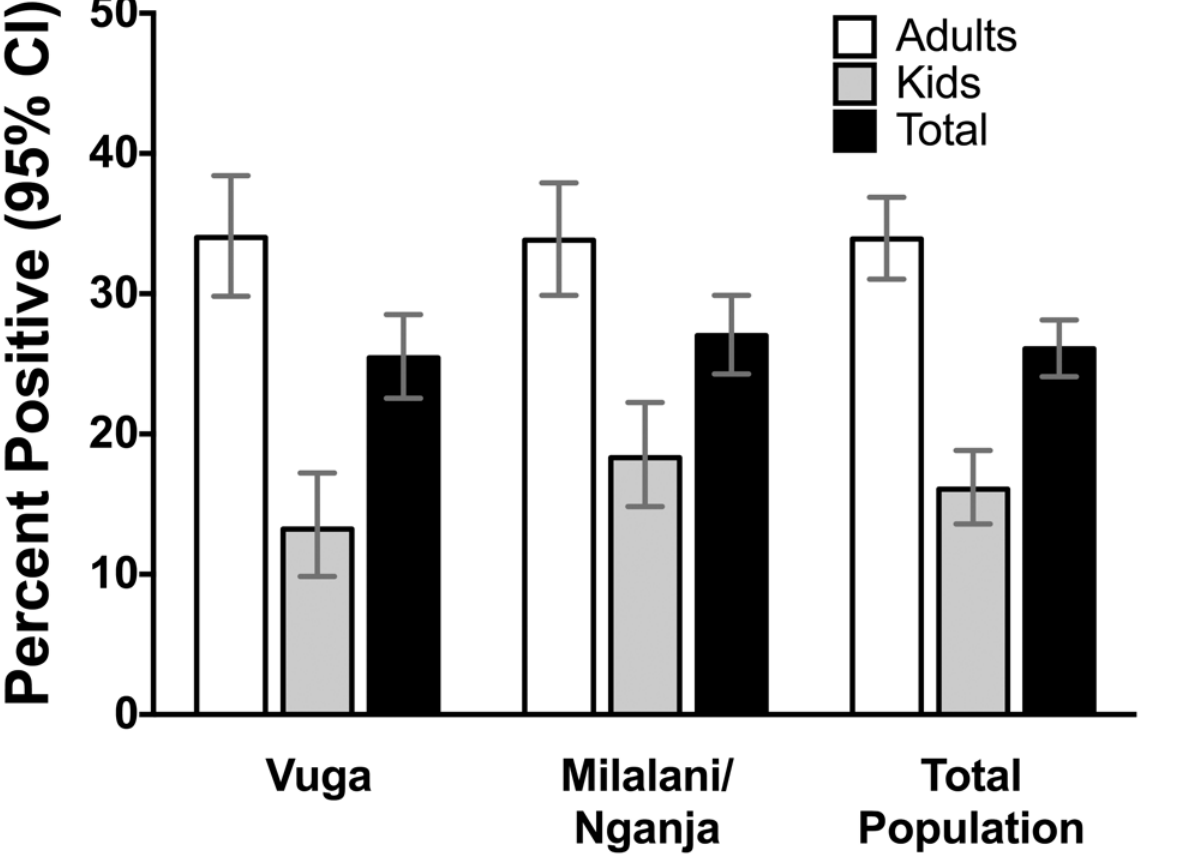
Figure 1. Alphavirus seroprevalence as measured by ELISA displayed by village and age group. 95% CI indicated by bars.